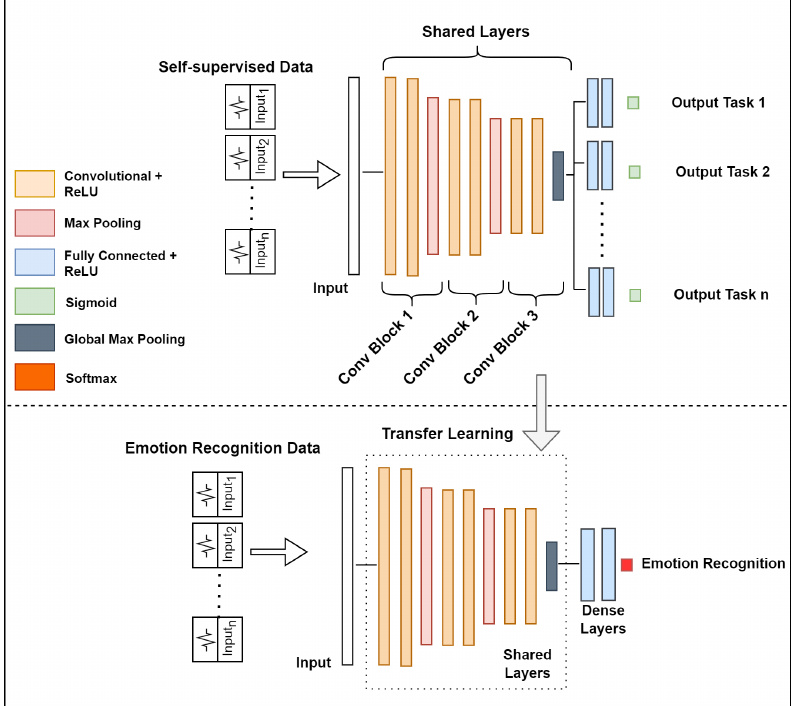
Figure 5. The architecture of the implemented convolutional neural network. The first stage is pre- training with 7 simultaneous tasks. The second stage is supervised training from the representation obtained in the self-supervised pre-training.